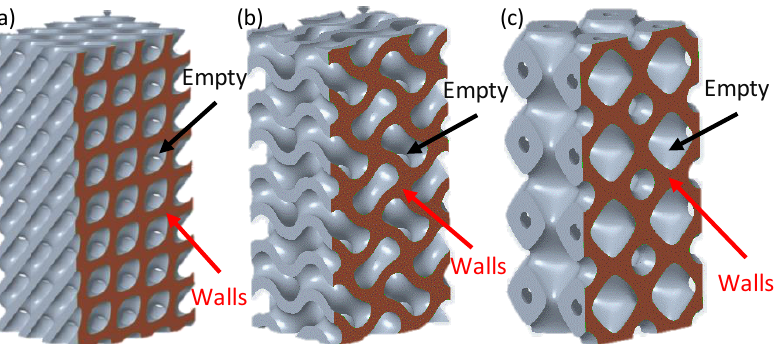
Figure 18. Cross-sectional of Lattice structures showing material distribution and empty spaces at 12 mm cell size and 44% RD: ( a ) Diamond, ( b ) Gyroid, and ( c ) Primitive.